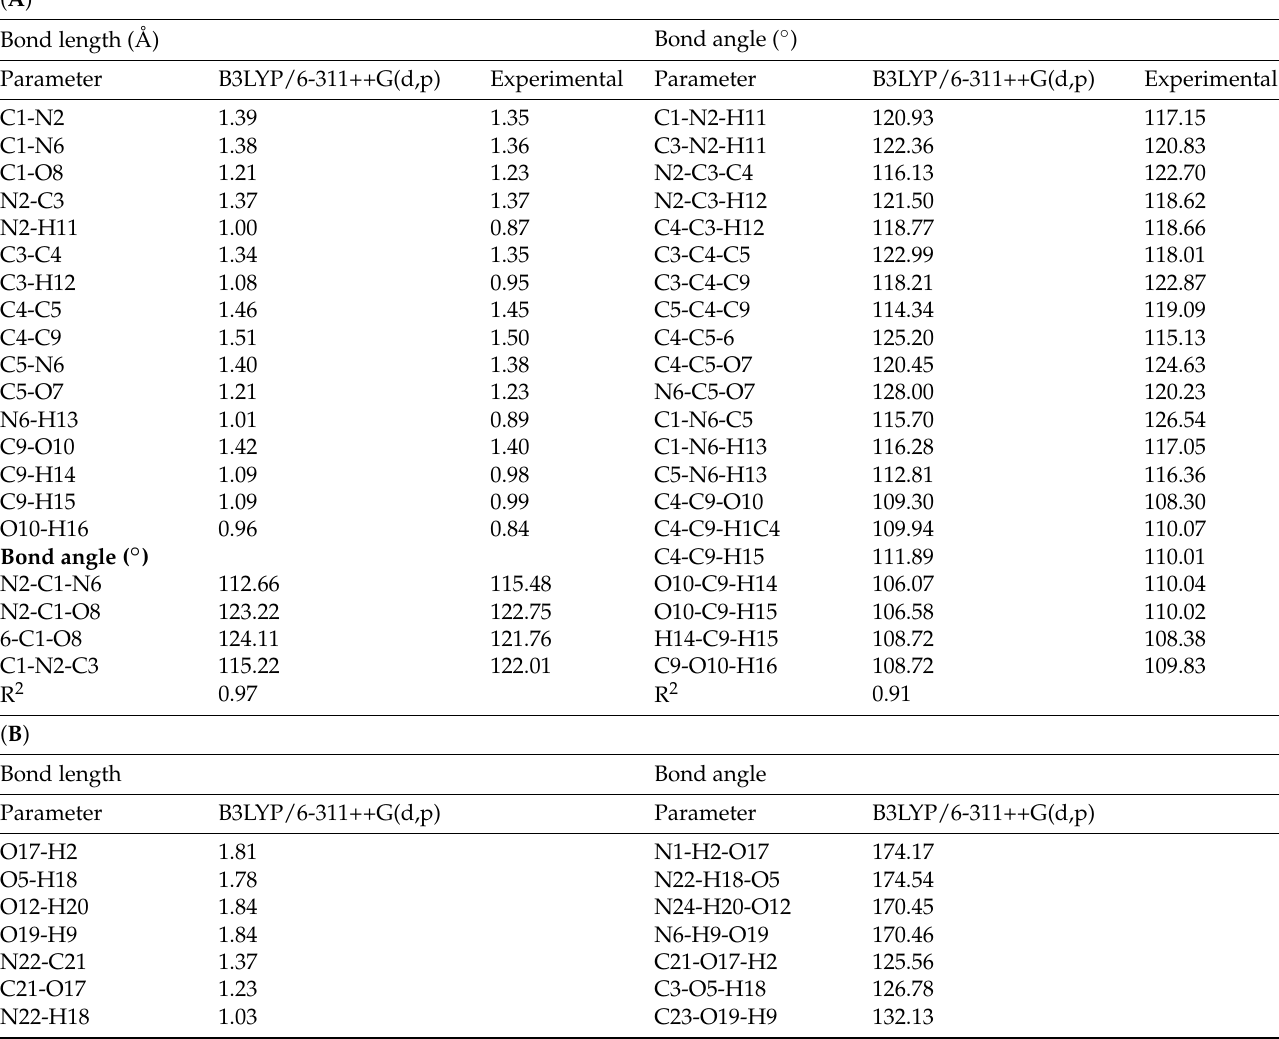
132.13 Each 5-HMU molecule is linked to each other via a hydrogen bond to form a trimer unit. In this case, the 2-N-H...O bonds hold within the 5-HMU trimer. The carbonyl and hydroxyl groups drive forming a trimer between monomer complexes in their close proximity. Figure 1 depicts the intermolecular hydrogen bond N-H...O formation based on the optimized structure (bond angles and distances) with the least amount of energy (Table 1B). Because of the inter-molecular interactions, the energy (E) of the trimer was found to be − 1588.58 a.u. with N–H . . . O bond lengths of 1.94 and 1.92 Å (Supplementary Materials, Figure S1). The bond angle of 174.17 ◦ and 174.54 ◦ in the trimer unit is almost linear. Two independent dimers exhibited by 5-HMU are shown in Figure 1C,D, and the parameters were summarized in Supplementary Materials; Tables S1 and